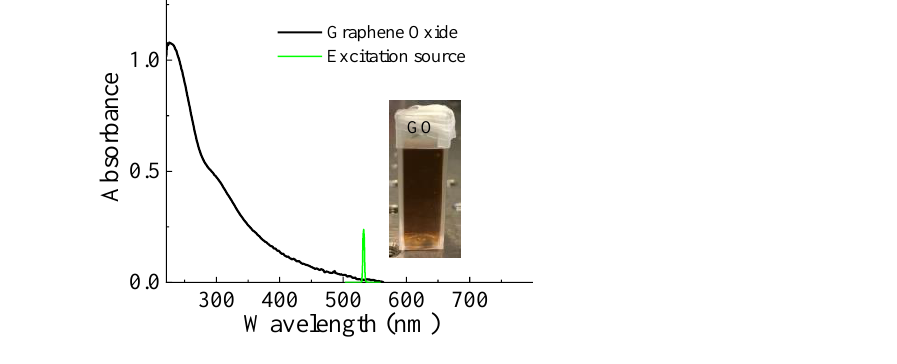
Figure 1. The absorption spectrum of graphene oxide atomic layers in the deionized water (DI) water (black), and the laser excitation source (green) at 532 nm for the SSPM. The nonlinear refraction coefficient of graphene oxide atomic layers in the aqueous base solution was investigated using the SSPM technique with a resonant excitation at 532 nm. The transverse intensity distribution of the Gaussian beam and the intrinsic nonlinear refraction coefficient of GO atomic layers make the phase differences between the spatial optical fields of the Gaussian beam. The coherent superposition of the optical fields for the concentric rings at the far field depends on the even or odd integer number of m π of nonlinear spatial phase shift ∆ φ NL = φ NL ( r 1 ) − φ NL ( r 2 ) at the arbitrary positions r 1 and r 2 of a gaussian beam with the equal transverse propagation wave vector δ k ( r ) . The maximum nonlinear phase shift ∆ φ NL ( 0 ) = k γ I ( 0 ) L ef f ≥ 2 π is the primary